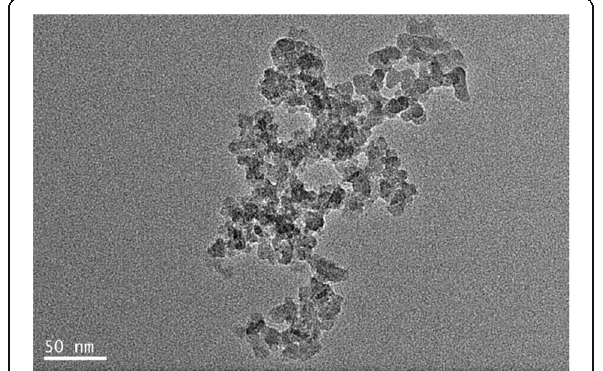
Fig. 1 The TEM micrograph of silica nanoparticles